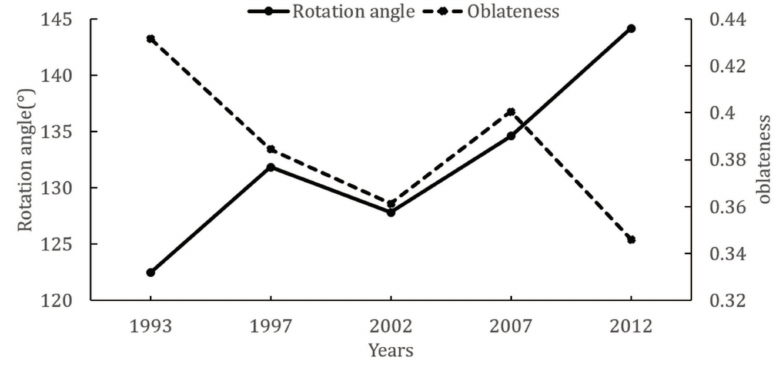
Figure 8. Plots of rotation angles and oblateness values for YRDUA SDEs for